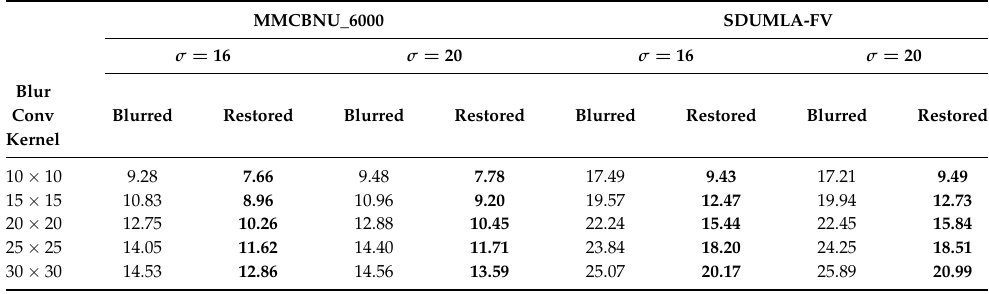
Table 5. EERs (%) of MMCBNU_6000 and SDUMLA-FV with different σ and blur Conv kernels. MMCBNU_6000 SDUMLA-FV σ = 16 σ = 20 σ = 16 σ = 20 Blur Conv Kernel